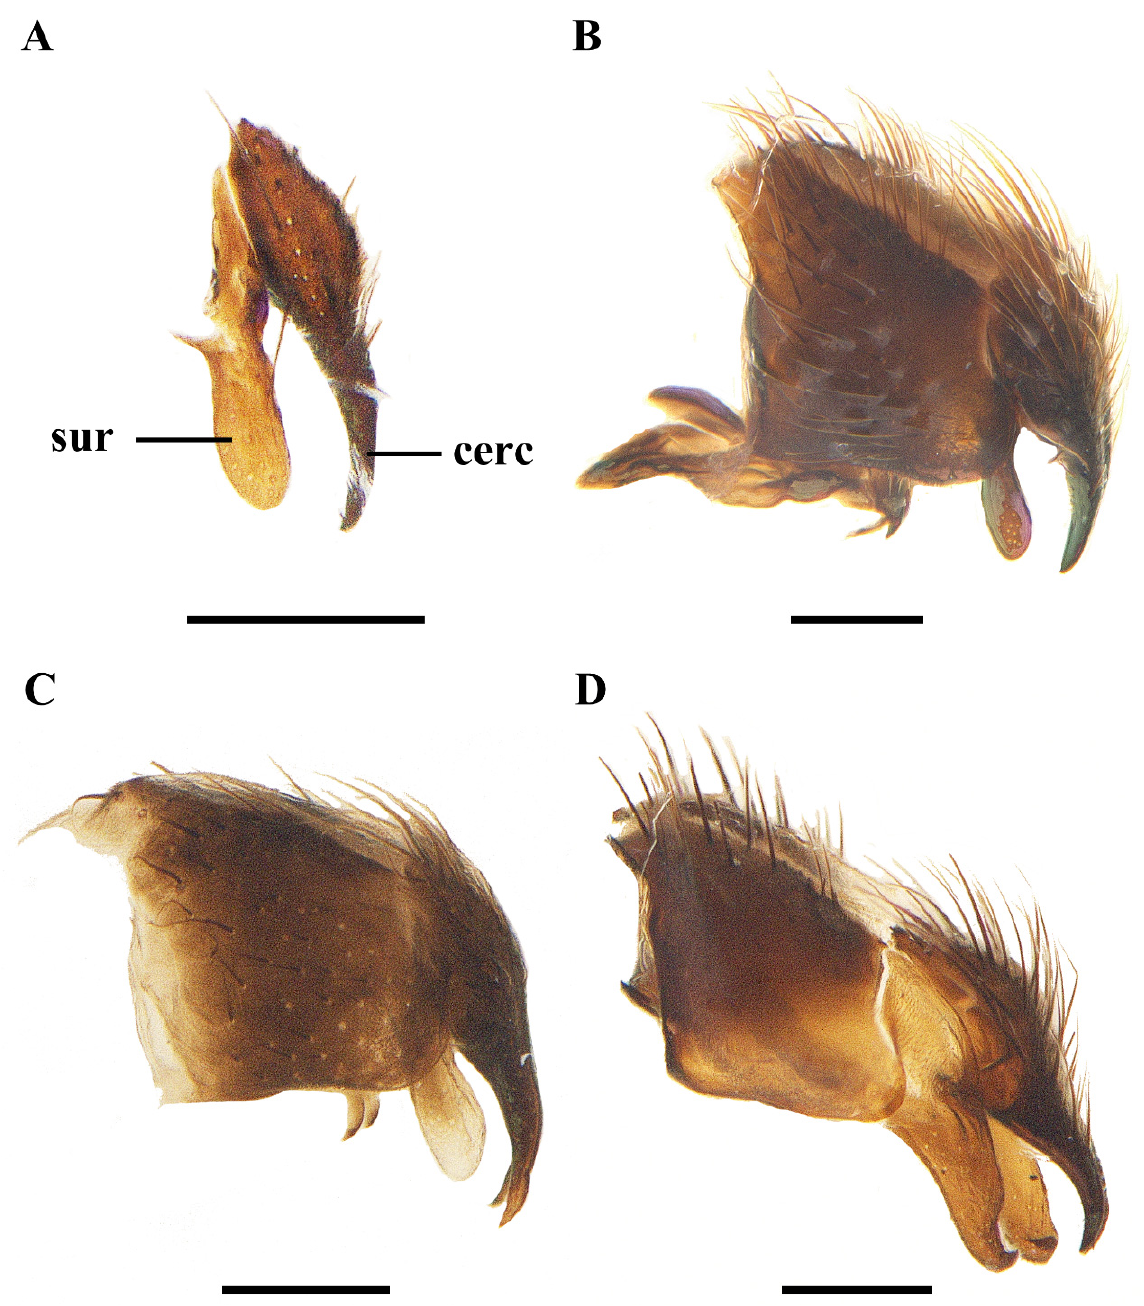
Figure 6. Lateral view of male terminalia of Macquartia spp. ( A ) M. brunneisquama sp. nov. ( B ) M. chinensis sp. nov. ( C ) M. flavipedicel sp. nov. ( D ) M. flavifemorata sp. nov. Scale bar = 0.2 mm. (Abbreviations: cerc = cercus; sur = surstylus.)